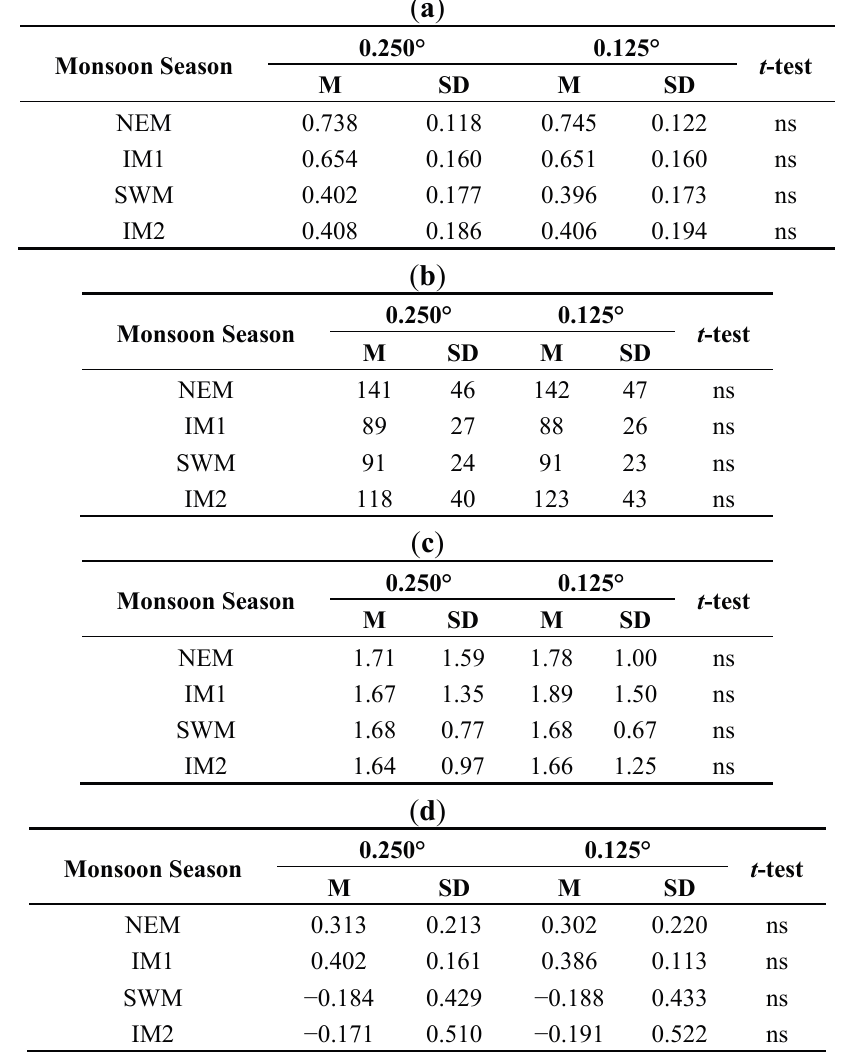
Table 2. T -test results comparing the 0.250° and 0.125° validation results. ( a )